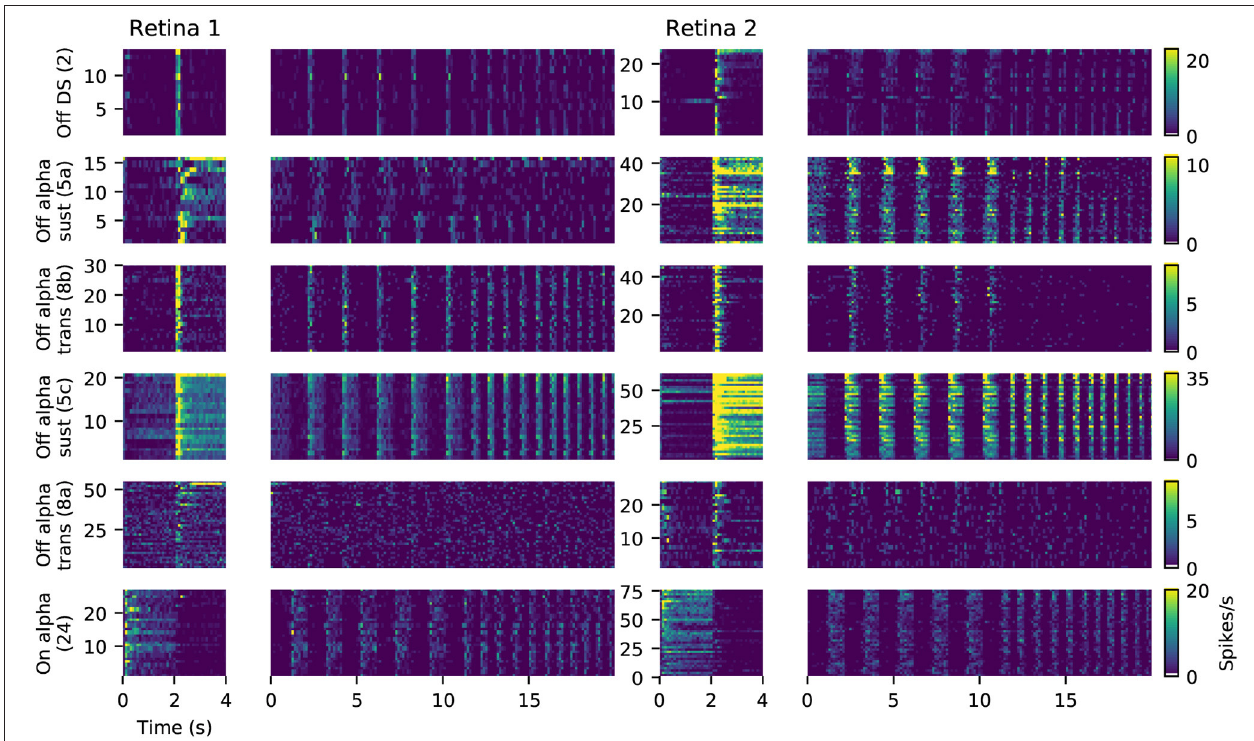
FIGURE 10 | Examples of matched cell types in two retinas. Each panel shows the PSTHs during full field stimulation (small, left) and the frequency-modulated part of the chirp stimulus (right), for all neurons clustered together as the same type. Data is the same as shown in Figure 9 . The color gradient indicating firing rates is peak-scaled to the largest response across all neurons in retina 1 for the chirp stimulus, separately for each type.